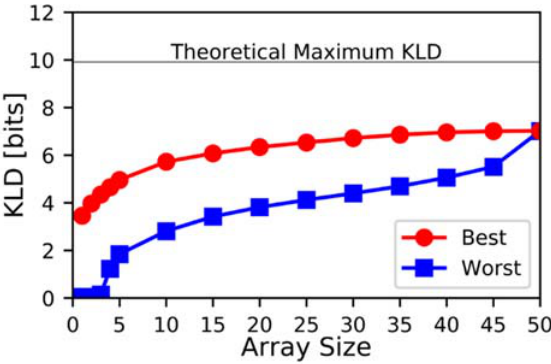
Figure 4. KLD in bits of best ‐ found and worst ‐ found as a function of the number of elements in array.